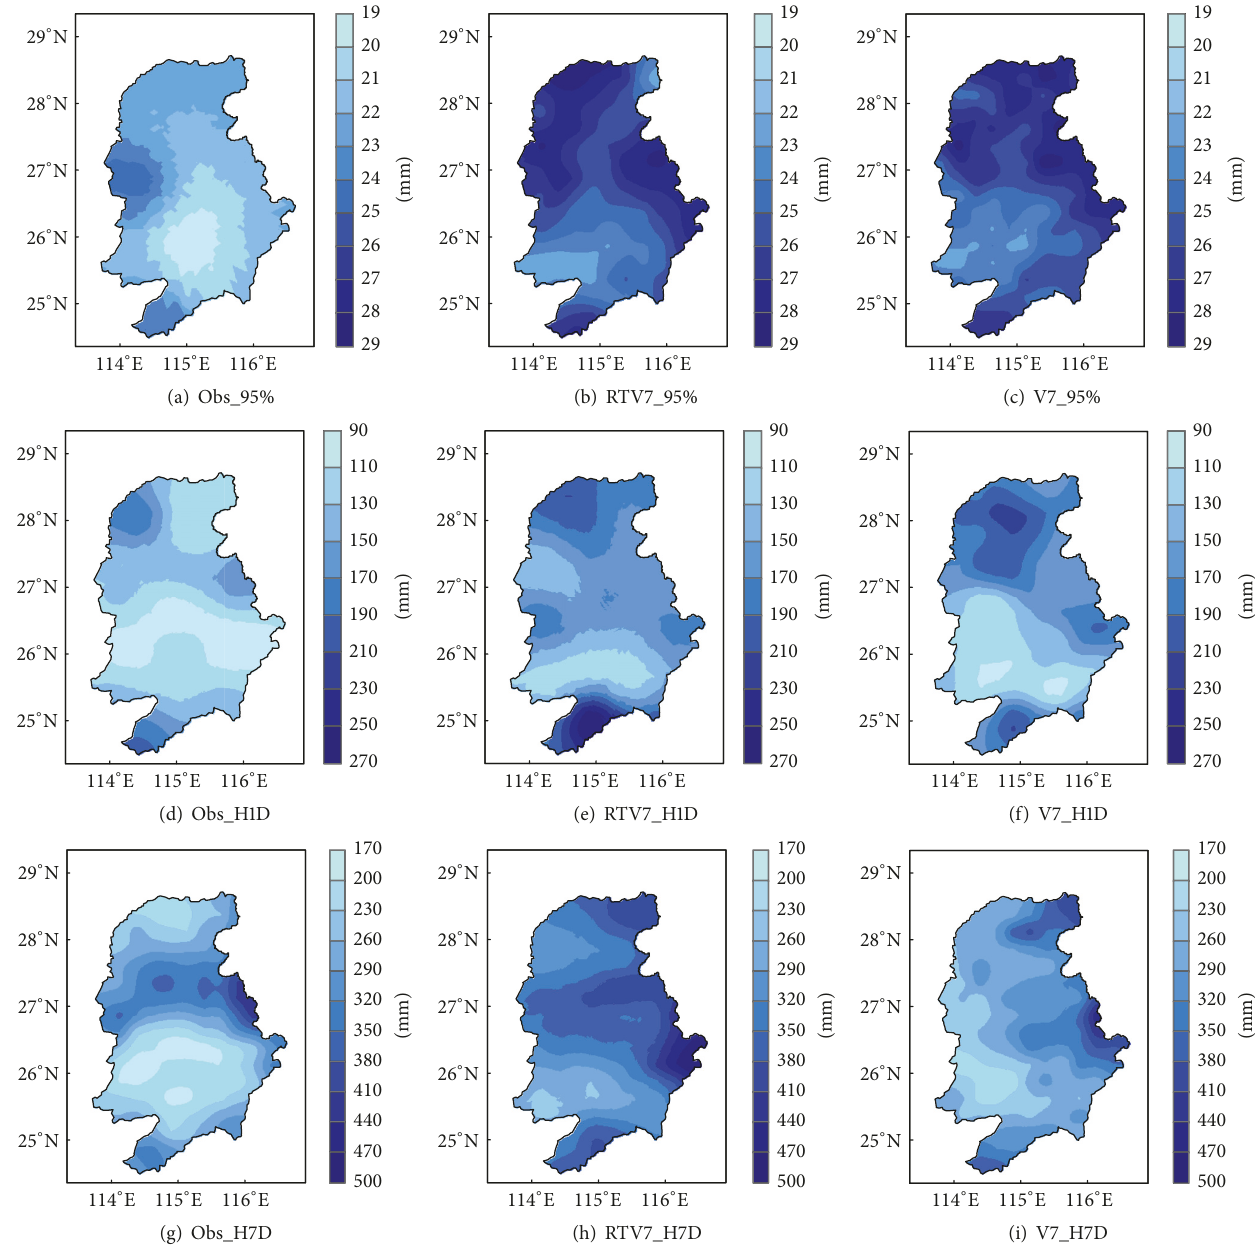
Figure 4: Spatial distribution of the extreme value of precipitation in the Ganjiang River basin from TMPA from 2003 to 2010.